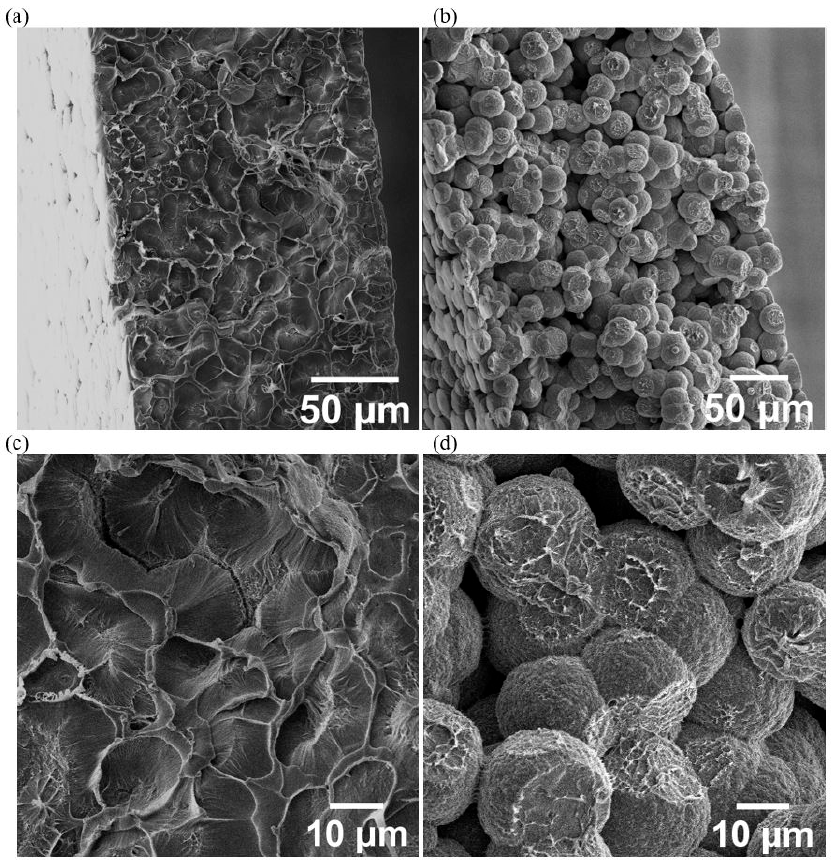
Figure 3. SEM micrographs of PVDF-HFP ionogel in cross-section after autoclave cure cycle